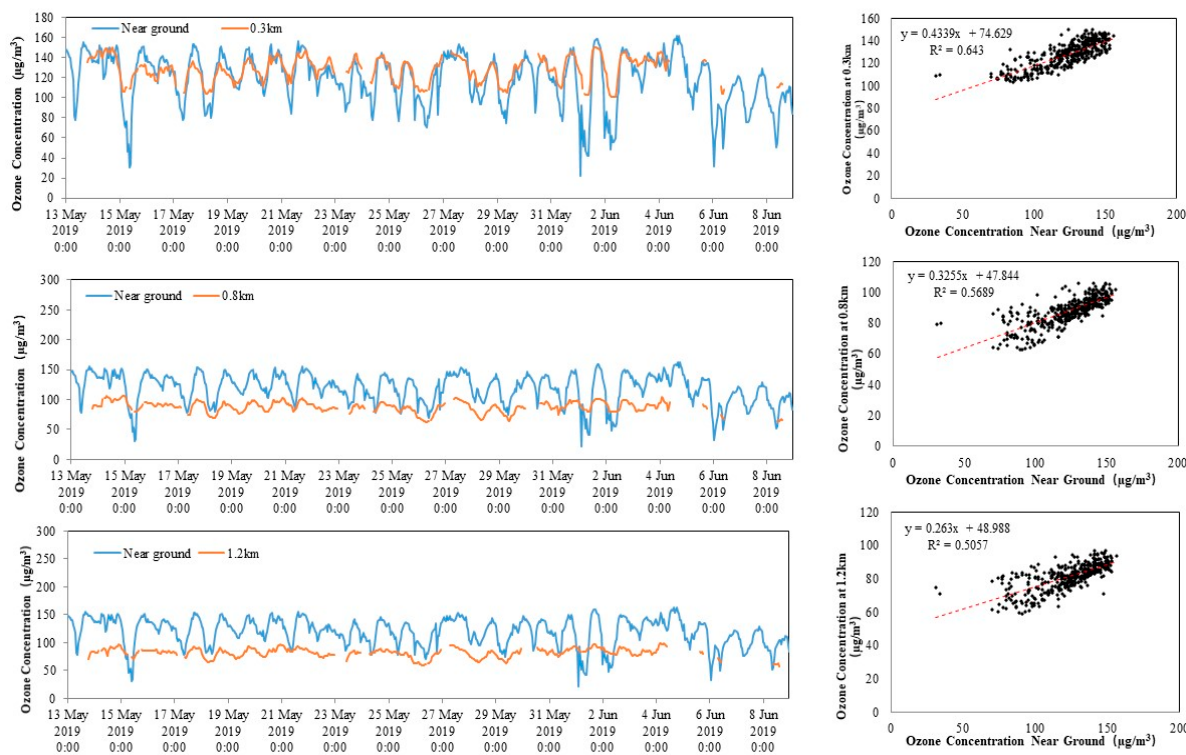
Figure 5. Ozone time series and comparisons between the near-ground ozone concentrations and those at 0.3 km, 0.8 km, and 1.2 km from 13 May to 31 May. Upper panel: near-ground and 0.3 km; middle panel: near-ground and 0.8 km; lower panel: near-ground and 1.2 km.